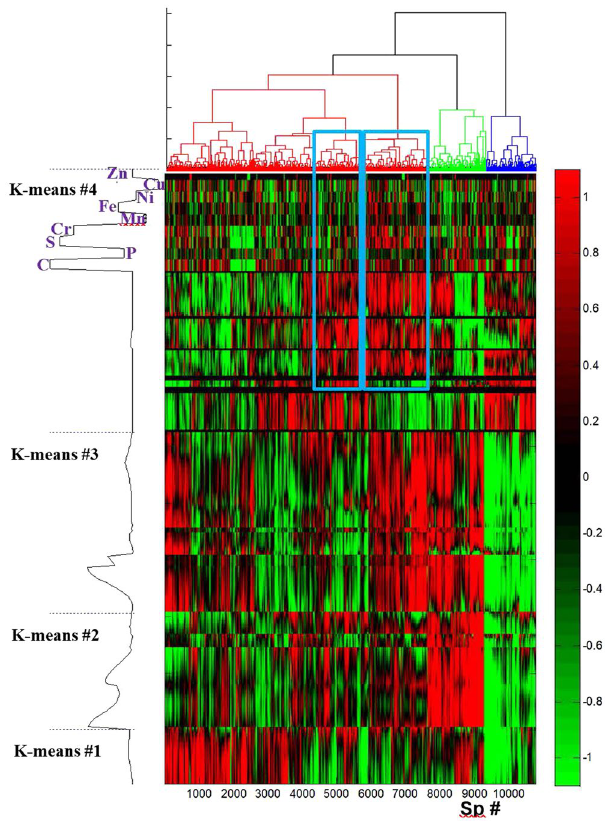
Figure 11. Representation of the intensities of the 10,780 FTIR/LA-ICP-MS spectra of section #3 presented on Fig. 8 passing a SNR threshold of 500 after double clustering analysis. Spectra were processed by subtraction of the mean and normalization by the standard deviation prior to clustering. The 10,780 spectra were sorted according to a hierarchical cluster analysis shown on top of the figure. The wavenumbers/elements were sorted in 4 clusters by K-means clustering. The dotted line on the left side of the figure indicates the limits of the clusters. The mean spectrum after sorting the wavenumbers/elements by the K-means (“sorted spectrum”) is also presented on the left side of the figure. For the sake of the clarity, the “sorted spectrum” is shown prior to mean subtraction and normalization by standard